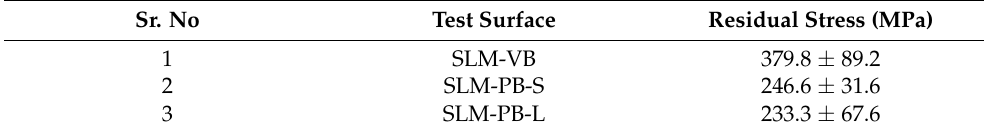
Table 6. The residual stress results of the surfaces of different samples. Sr.